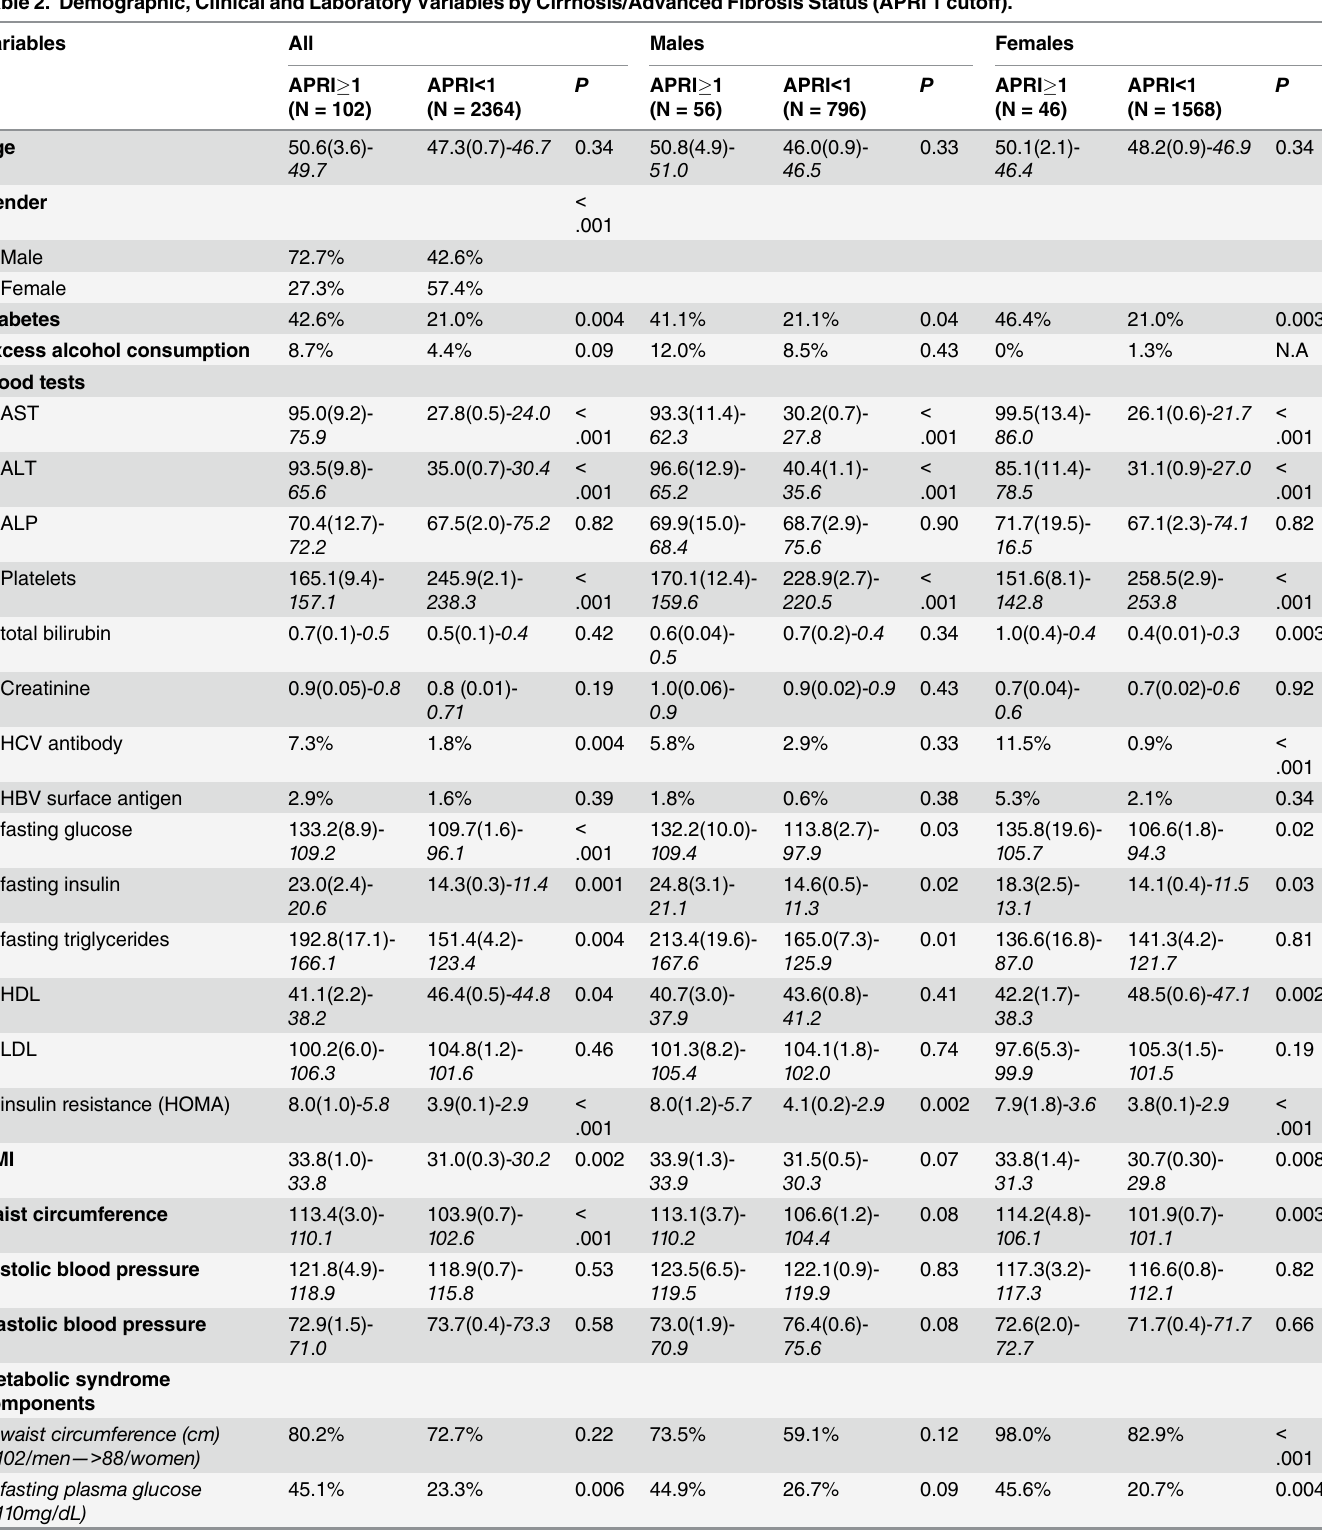
Table 2. Demographic, Clinical and Laboratory Variables by Cirrhosis/Advanced Fibrosis Status (APRI 1